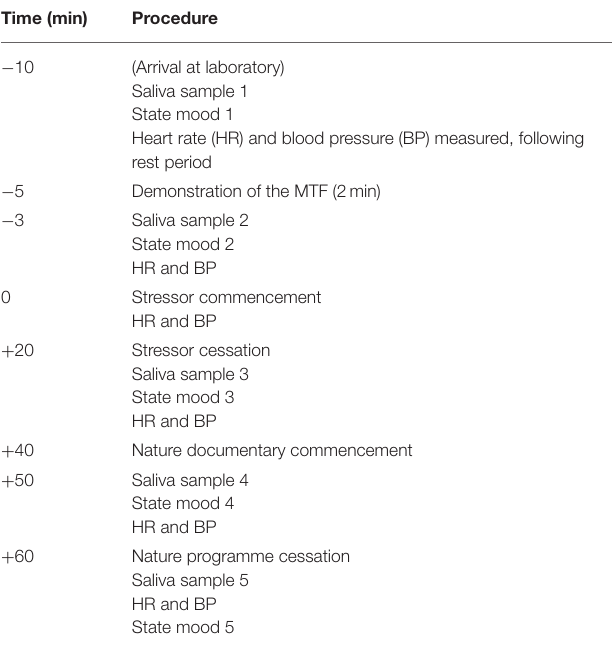
TABLE 1 | Protocol timeline and sampling procedure: time (minutes) of each procedure prior/subsequent to the stress task displayed in the left column. Time